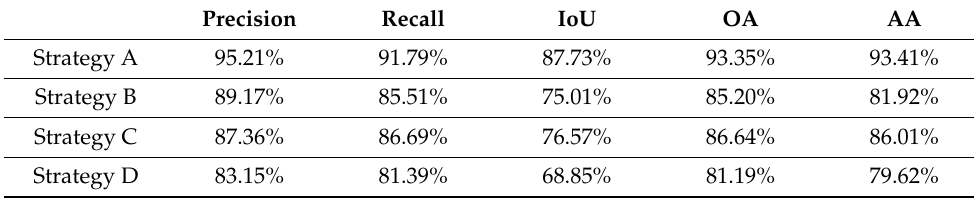
Table 11. Quantitative evaluation of different strategies for the ablation study. Precision